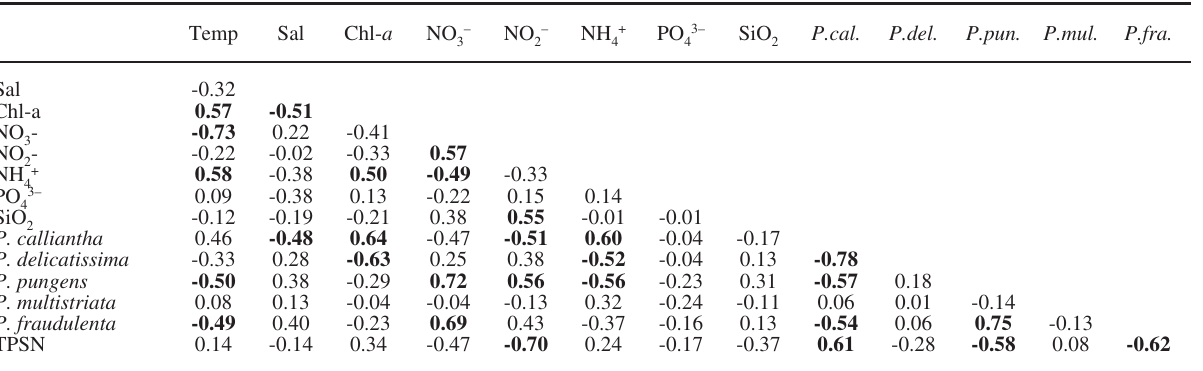
Table 5. – Spearman correlation coefficients for transformed abiotic and biotic variables: temperature (temp), salinity (Sal), chlorophyll a concentration (chl- a , µg l -1 ), dissolved inorganic nutrients (µM), Pseudo-nitzschia abundance per species (cells l -1 ) and total Pseudo- nitzschia abundance (tpSn). Significant ( p <0.01) correlations are indicated in bold. P.cal., P.calliantha ; P.del., P. delicatissima ; P.pun., P. pungens ; P.mul., P. multistriata ; P.fra., P.